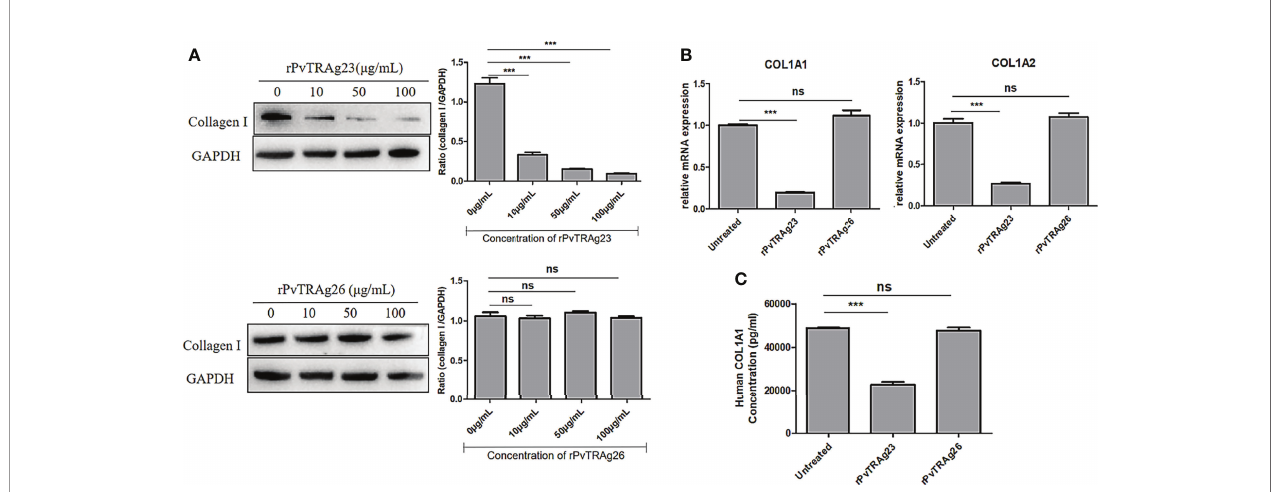
FIGURE 2 | The levels of collagen I secreted by HSFs after stimulated by recombinant proteins. (A) 5 × 10 6 HSFs were cultured with rPvTRAg23 and rPvTRAg26 at the corresponding concentration. After 48 h, the cells were lysed and the collagen I expression in HSFs was measured by western blot (left), the gray values were compared between the two groups using GAPDH as internal reference (right). (B) 5 × 10 6 HSFs were treated with 50 m g/mL rPvTRAg23 or PvTRAg26 for 48 (h) Untreated cells were set for control, and collagen mRNA levels of cells were detected by qPCR. Three individual experiments have been performed. (C) Supernatants of HSFs culture were collected to detect collagen I content after 5 × 10 6 HSFs were stimulated by 50 m g/mL rPvTRAg23 or rPvTRAg26 for 48 h. Each sample was assayed in triplicate at 450 nm and the collagen I concentrations in supernatant were expressed in pg/mL. Statistical analyses were carried out by one-way ANOVA with Dunnett ’ s multiple comparisons test. (ns, P > =0.05; *** P <